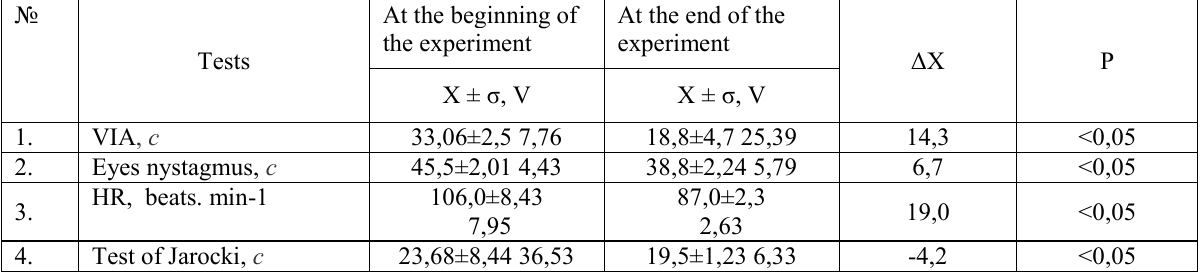
Dynamics of indicators of sustainability of the vestibular analyzer young fighters all-rounders aged 6-8 years involved in military-sports all around the experimental program (the experimental group, n=20).